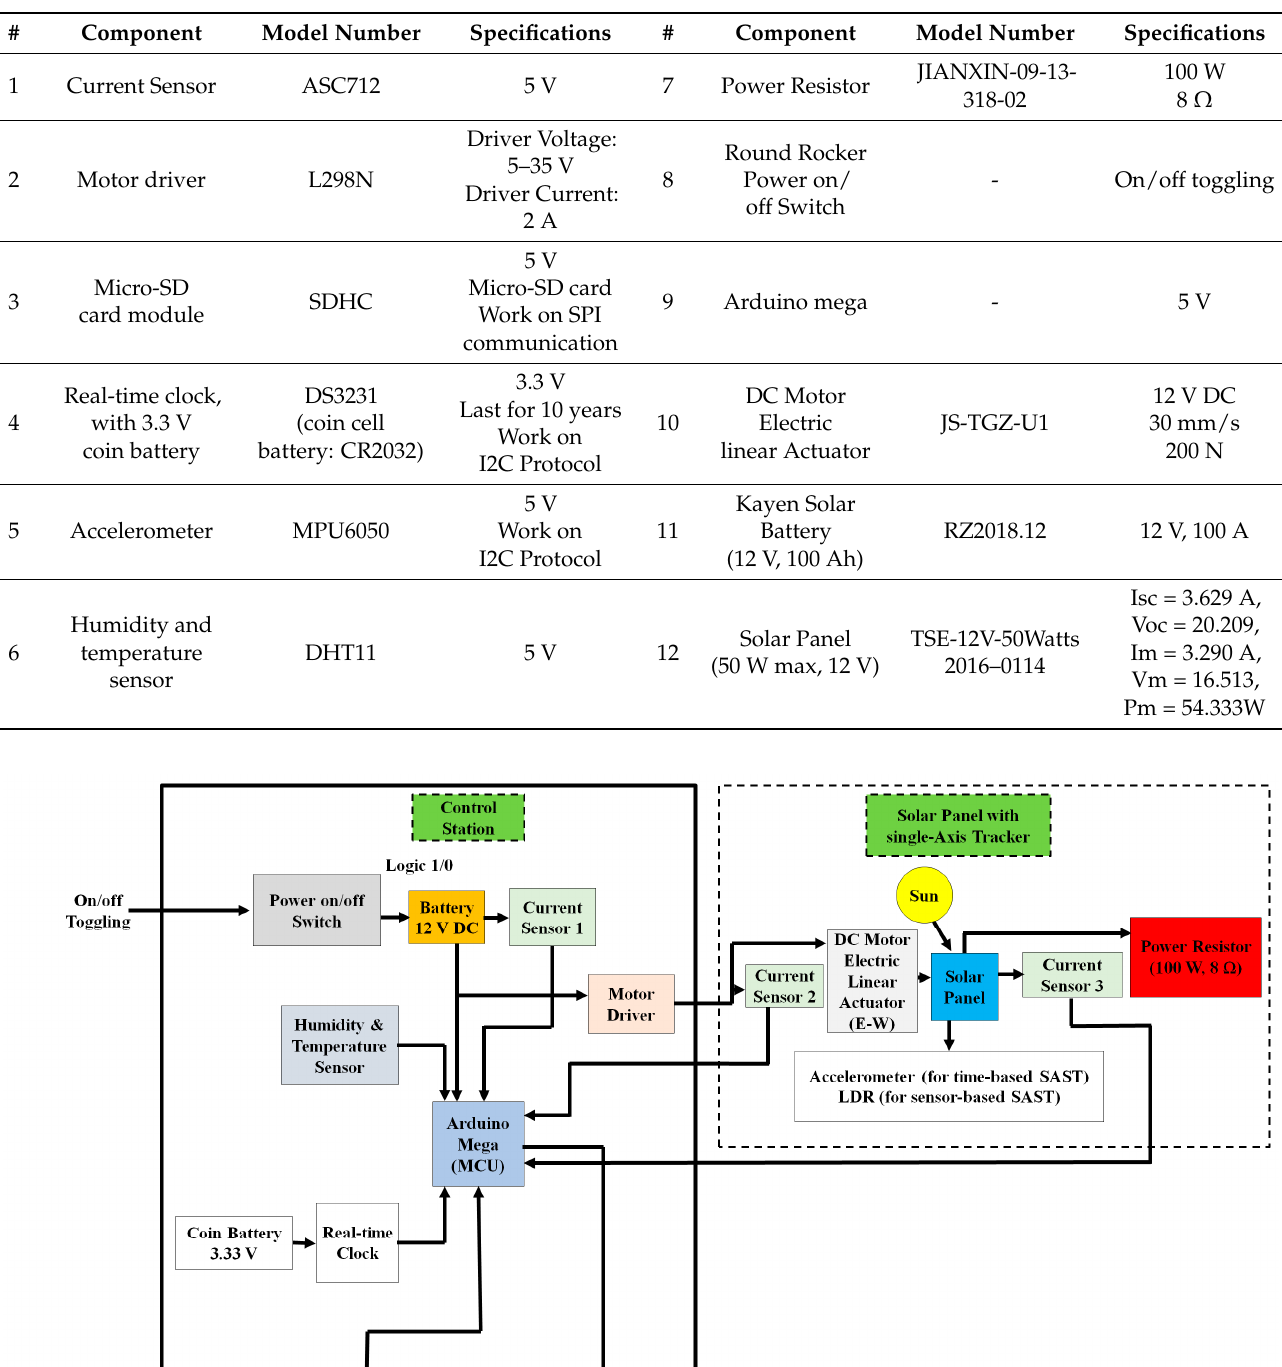
Table 1. The electrical component.